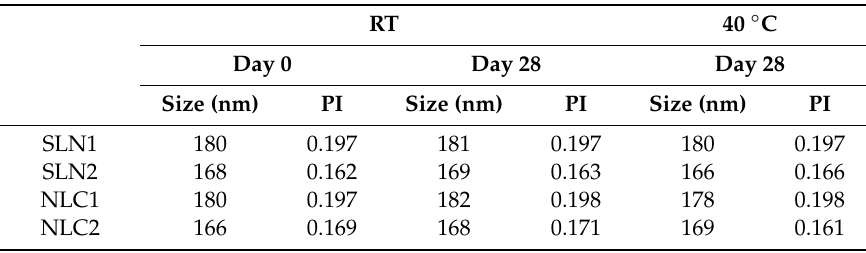
Table 2. Particle sizes of SLN and NLC.